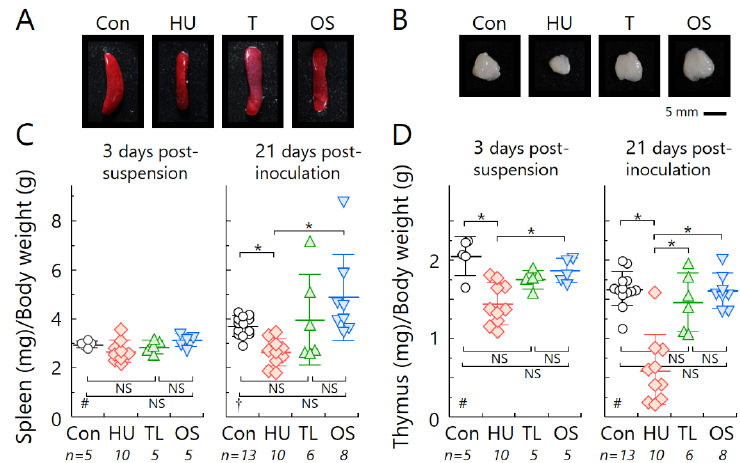
Figure 1. Lymphoid organ atrophy in the four suspension conditions was measured at 3 days after suspension and at 21 days after tumor cell inoculation. ( A , B ) Representative photographs at 21 days after tumor cell inoculation. ( C , D ) Organ weight relative to body weight. ( A , C ) Spleen. ( B , D ) Thymus. Circles, standard housing control group (Con); diamonds, hind-limb unloading (HU); triangles, temporary loading during HU (2 h per day) (TL); inverted triangles, orthostatic suspension (OS). Error bars indicate standard errors. # , ANOVA test; † , Kruskal-Wallis test. * p < 0.05; NS, not significant.